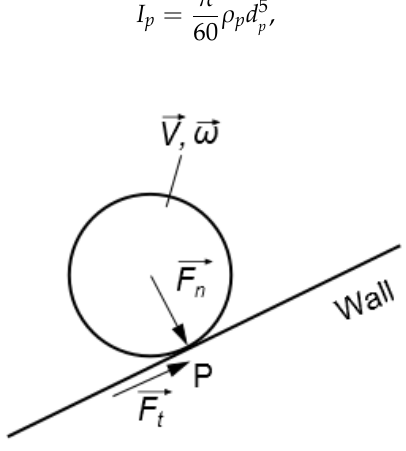
Figure 3. Rotation diagram of particle collision wall.